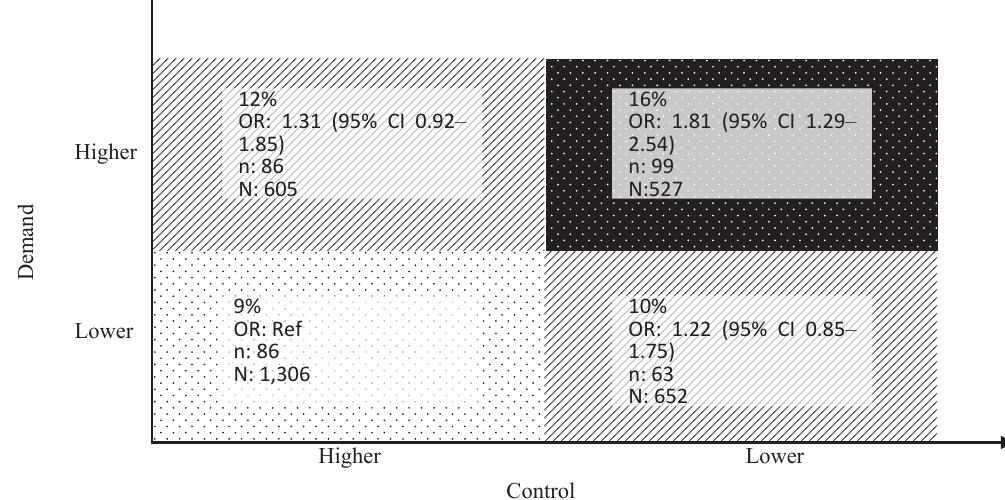
Figure 1. Percentages and odds ratios of participants whose pre-existing disease was aggravated according to job strain during the fi rst state of COVID-19 emergency in Japan. Percentages (n / N) were adjusted for age and sex using general linear